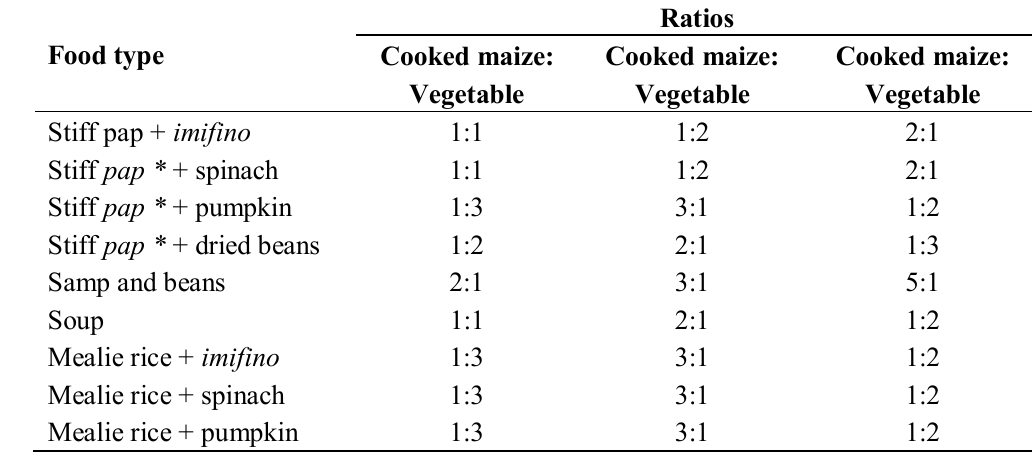
Table 5. Ratios depicted on the